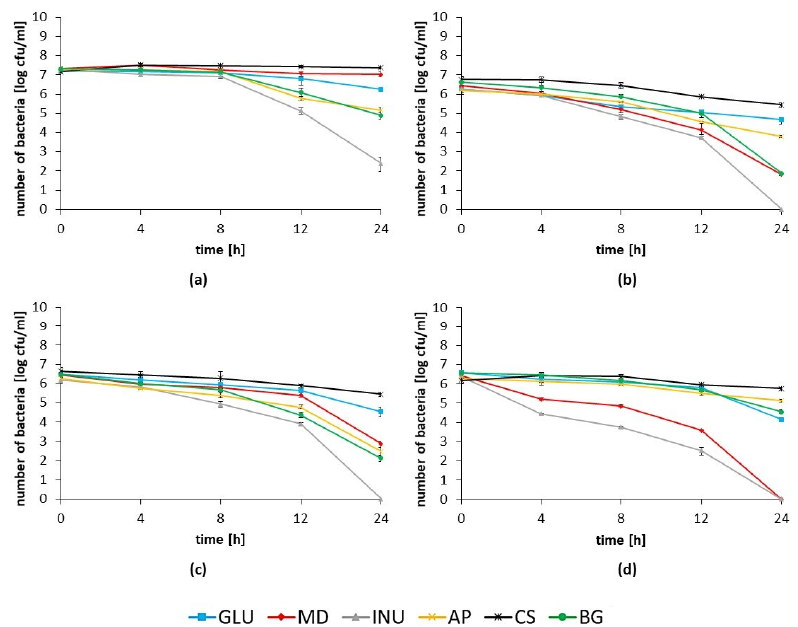
Figure 3. Antagonistic activity of a mixture of the probiotic strains, namely, Lb. rhamnosus Ł OCK 1087, 1087, Lb. paracasei ŁOCK 1091, Lb. reuteri ŁOCK 1092, Lb. plantarum ŁOCK 0860, and Lb. Lb. paracasei Ł OCK 1091, Lb. reuteri Ł OCK 1092 , Lb. plantarum Ł OCK 0860, and Lb. pentosus Ł OCK 1094 on the pathogenic bacteria: (a) L. monocytogenes , (b) S. Enteritidis, (c) S . Typhimurium, and (d) S .